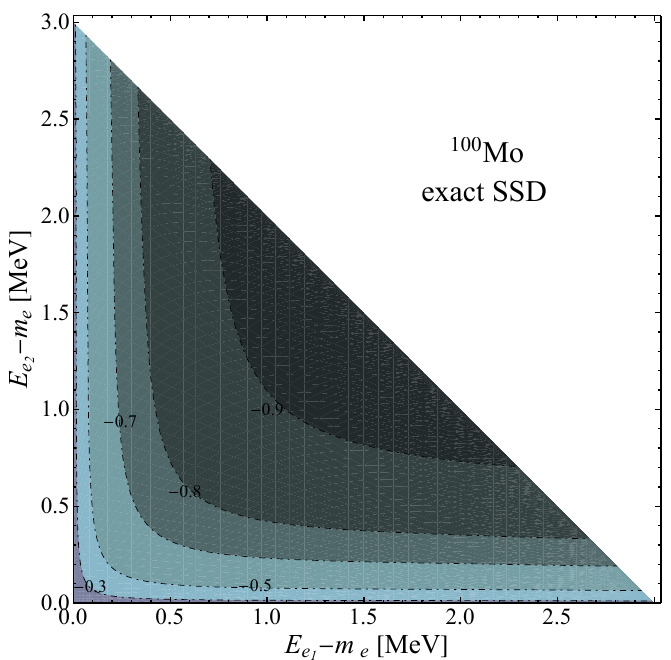
Figure 6. The angular correlation κ 2 ν as function of energies of electrons emitted in 2 νββ -decay of 100 Mo. The distribution is obtained using the exact SSD formalism presented in [21,22] and the screened exact finite-size Coulomb wave functions for s 1/2 electron